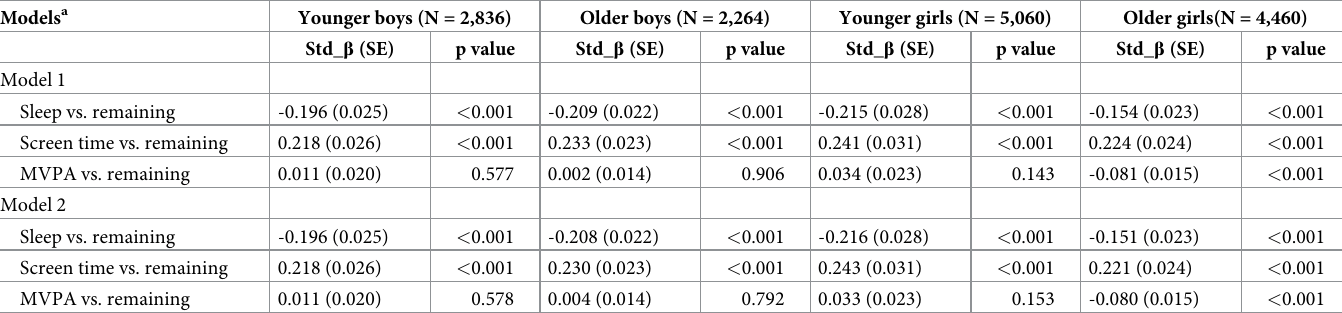
Table 3. Longitudinal associations between changes in first pivot coordinate coefficient (standardized betas) and change in depressive symptoms. Models